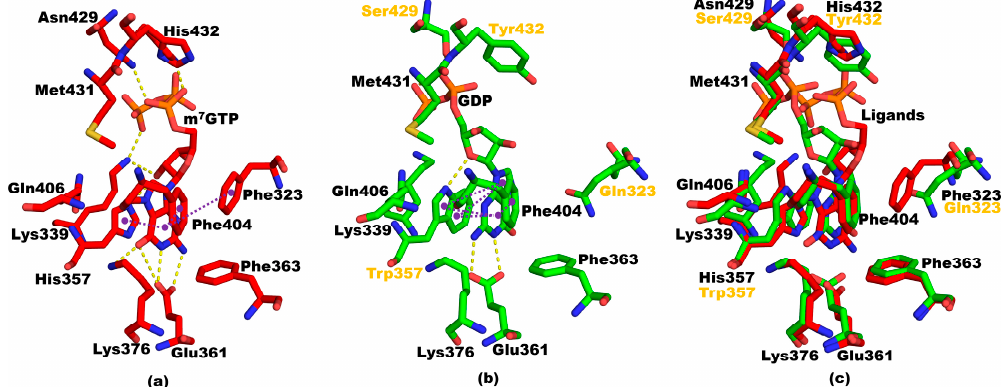
Figure 8. ( a ) Mutant PB2cap from A/California/07/2009 (H1N1) bound to m 7 GTP (PDB code: 5EG7) (red) [10]; ( b ) PB2cap from B/Jiangxi/BV/2006 PB2cap bound to GDP (PDB code: 4Q46) (green) [15]; ( c ) 5EG7 (red) superposed with 4Q46 (green). The gold residue labels highlight the differences in 4Q46 relative to 5EG7. Hydrogen bonds are depicted with yellow dotted lines, and π - π force interactions are depicted with purple dotted lines [10,23,25].